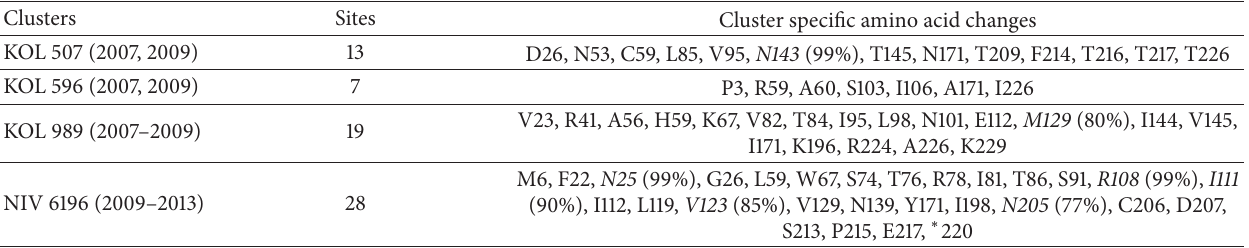
Table 5: Cluster specific amino acid changes were seen in all the sequences of cluster and were absent from sequences of all other clusters. Clusters